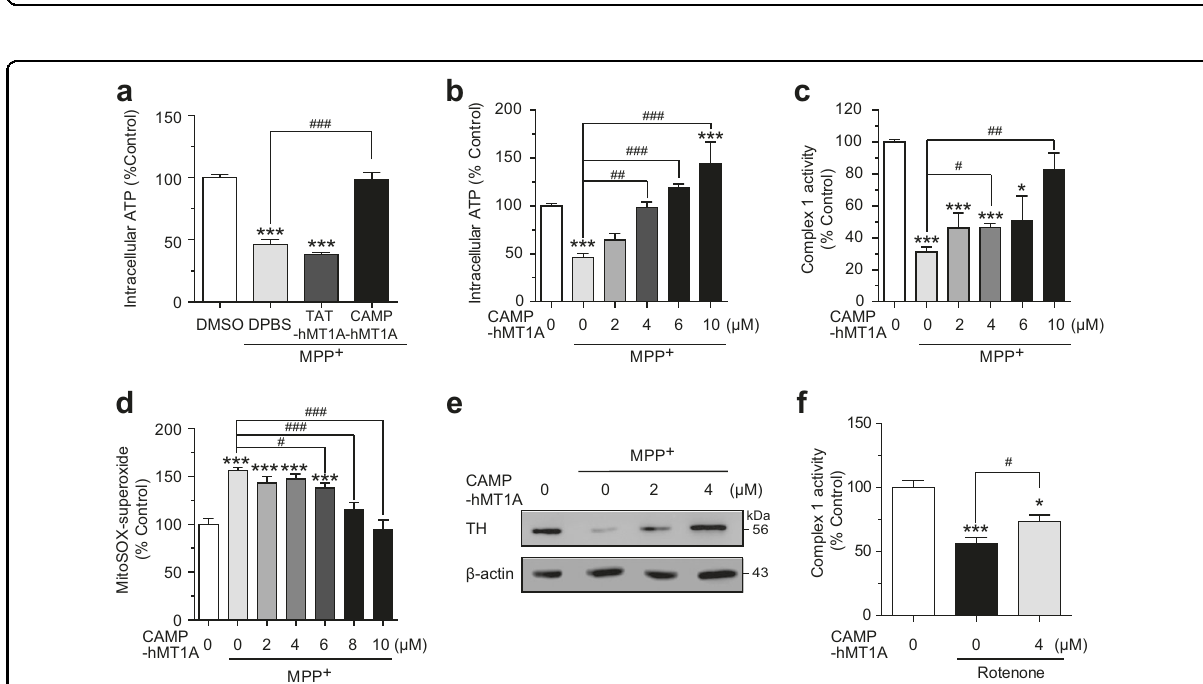
Fig. 6 Recovery of mitochondrial activity and TH expression by CAMP-hMT1A in cellular PD models. a Intracellular ATP content of SH-SY5Y cells treated with 1 mM MPP + for 24 h, followed by treatment with 4 μ M CAMP-hMT1A or TAT-hMT1A ( n = 4). b – e Dose-dependent effects of CAMP- hMT1A in MPP + -treated SH-SY5Y cells: b intracellular ATP ( n = 12); c complex 1 of OXPHOS, NADH dehydrogenase activity ( n = 4); d superoxide level as determined by MitoSOX ( n = 6); e TH expression as determined by western blot with β -actin loading control. f Effects of CAMP-hMT1A on complex 1 activity in cells treated with 1 μ M rotenone for 24 h ( n = 3). The data are presented as the mean ± SEM. * P < 0.05, ** P < 0.01, *** P < 0.001 vs. CTL; # P < 0.05, ## P < 0.01, ### P < 0.001 vs. MPP +